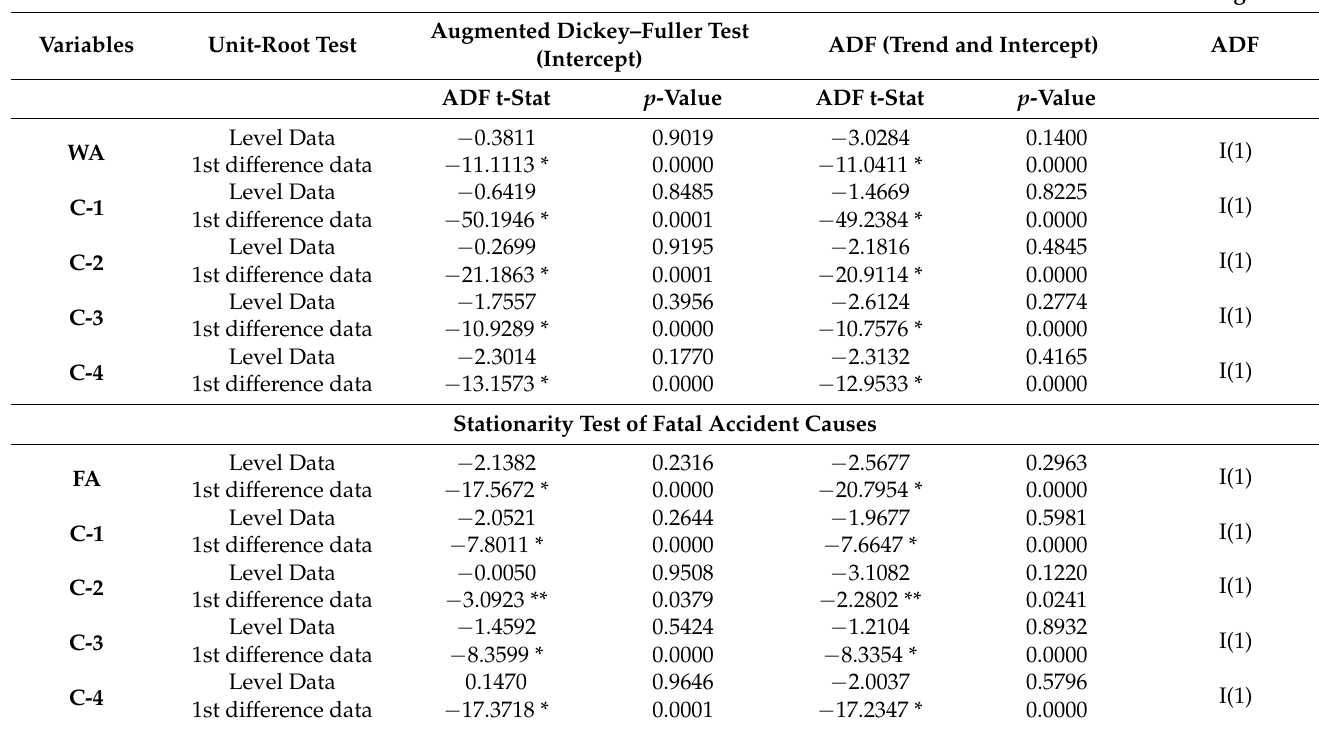
Table 2. Augmented Dickey–Fuller